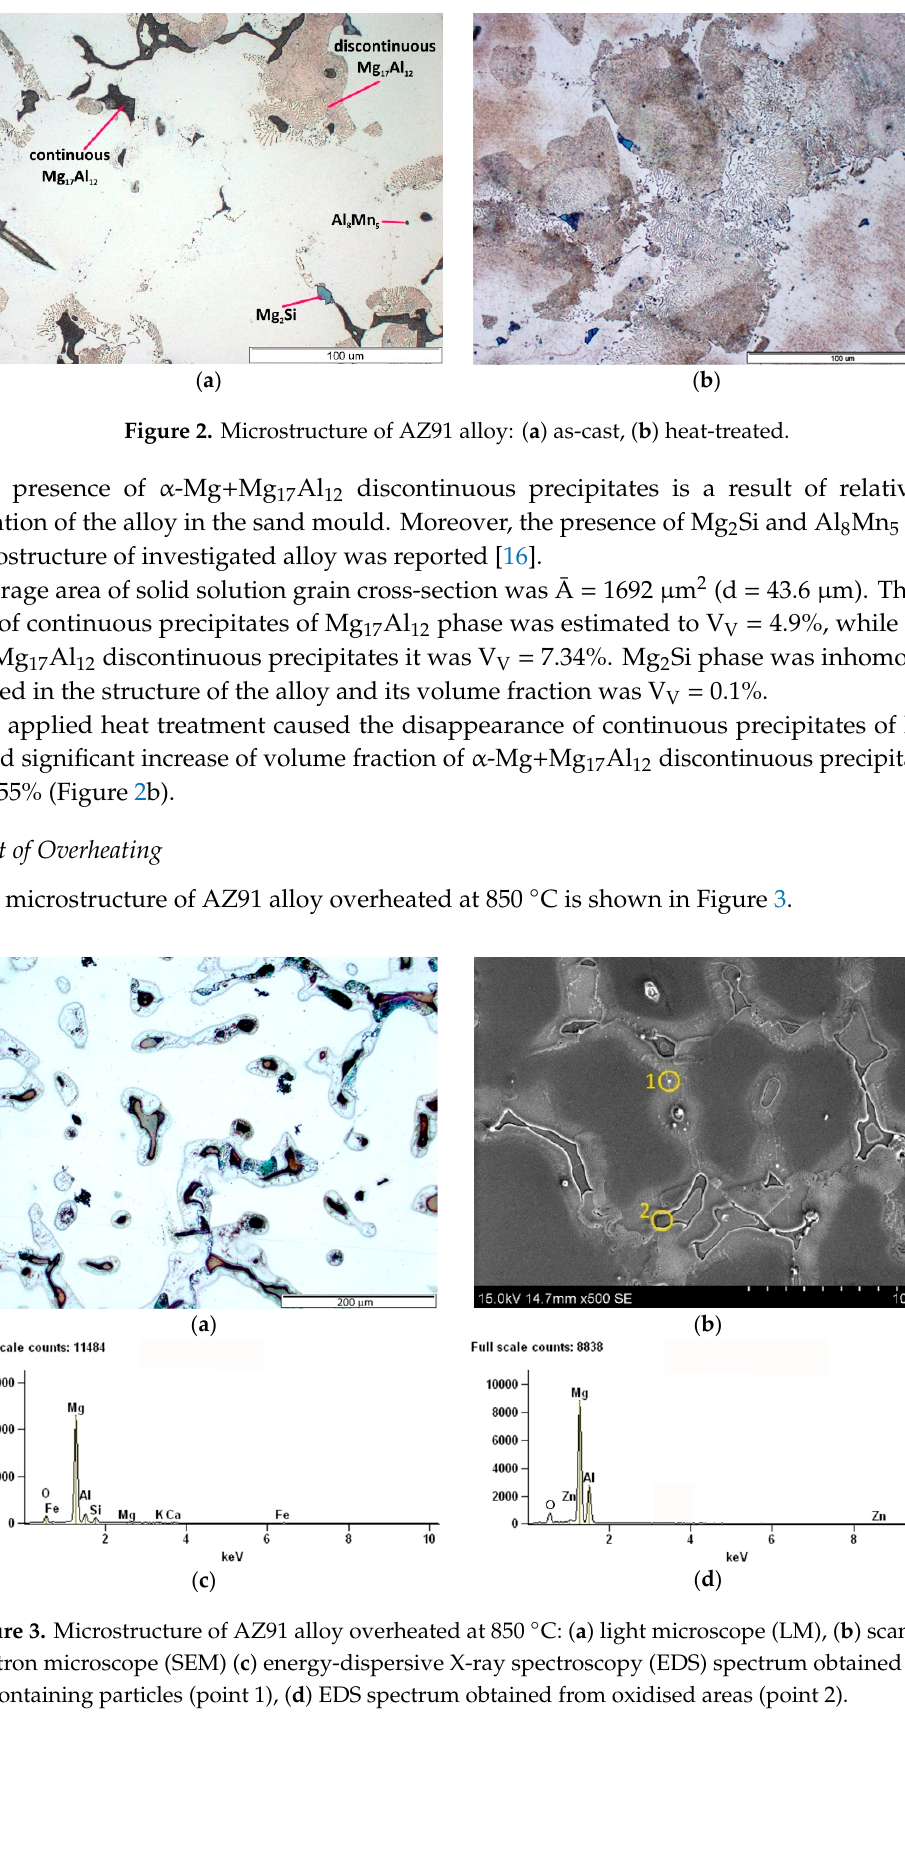
Figure 3. Microstructure of AZ91 alloy overheated at 850 °C: ( a ) light microscope (LM), ( b ) scanning electron microscope (SEM) ( c ) energy-dispersive X-ray spectroscopy (EDS) spectrum obtained from Fe-containing particles (point 1), ( d ) EDS spectrum obtained from oxidised areas (point 2).